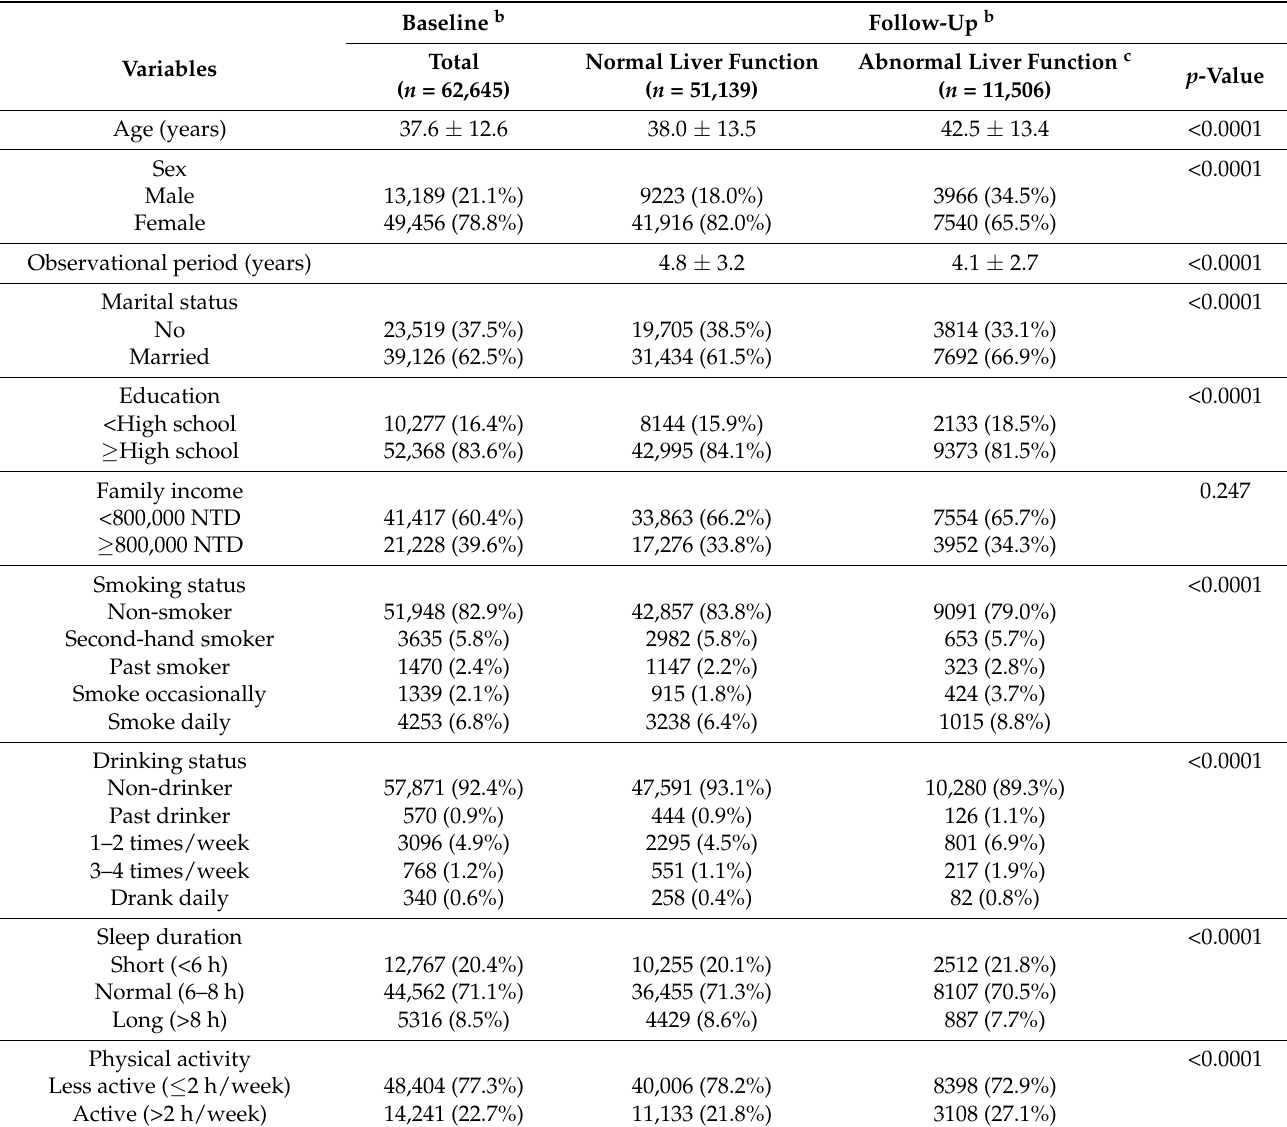
Table 1. Demographic and lifestyle characteristics of study participants classified by liver function ( n = 62,645) a